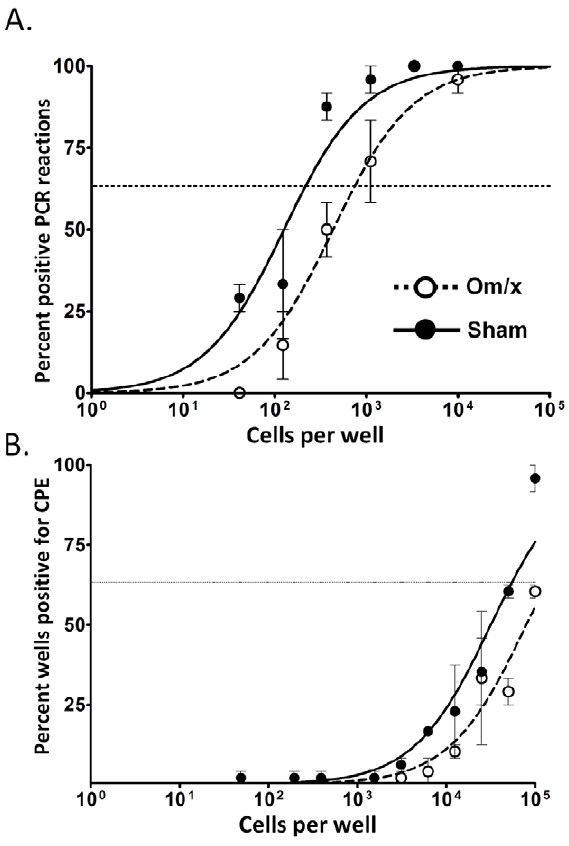
Figure 7. Reduced establishment in omentectomized mice during early latency. Mice underwent omentectomy or sham surgery and allowed to recover for four weeks, then were inoculated i.p. with 1000 pfu virus. Spleen and omenta were harvested at day 18 post- infection and single cell suspensions analyzed by limiting dilution reactivation analyses (A), or used for limiting dilution PCR analyses (B). A) Frequency of CPE in MEF monolayers after limiting-dilution plating of intact cells as evidence of virus reactivation. Mechanically-disrupted cells were plated in parallel to control for the presence of preformed infectious virus (data not shown). B) Frequency of positive PCR reactions after limiting-dilution plating and DNA-quantity-controlled PK digest/